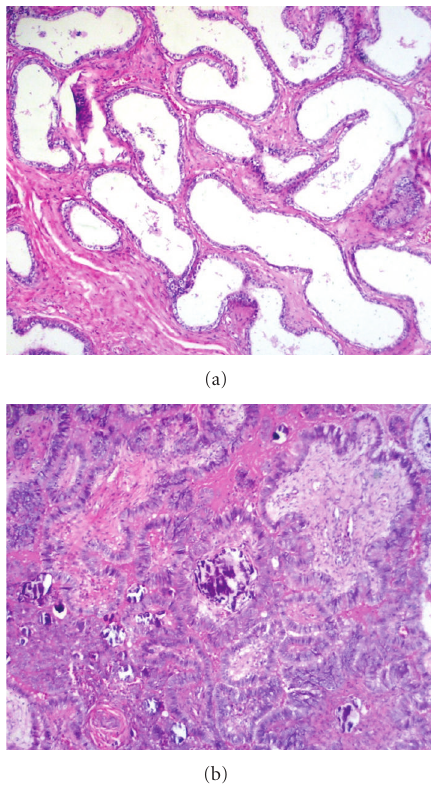
Figure 2: Histological H&E stain of (a) normal microscopic pictures of rete testis, and (b) hyperchromatic cells (100x).